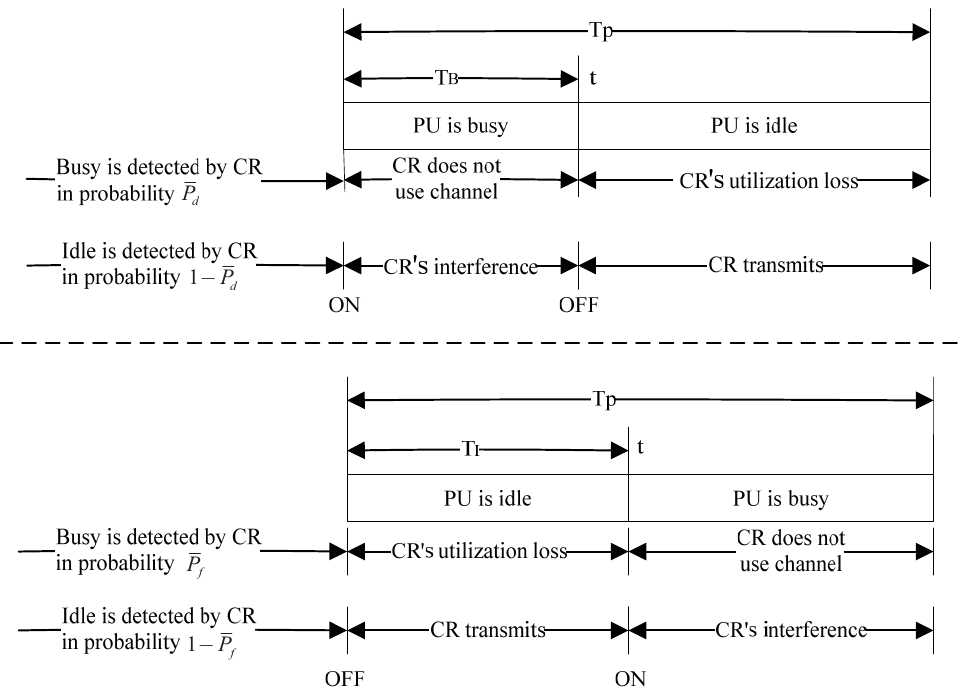
Figure 4. Interference and loss of spectrum access during one period.